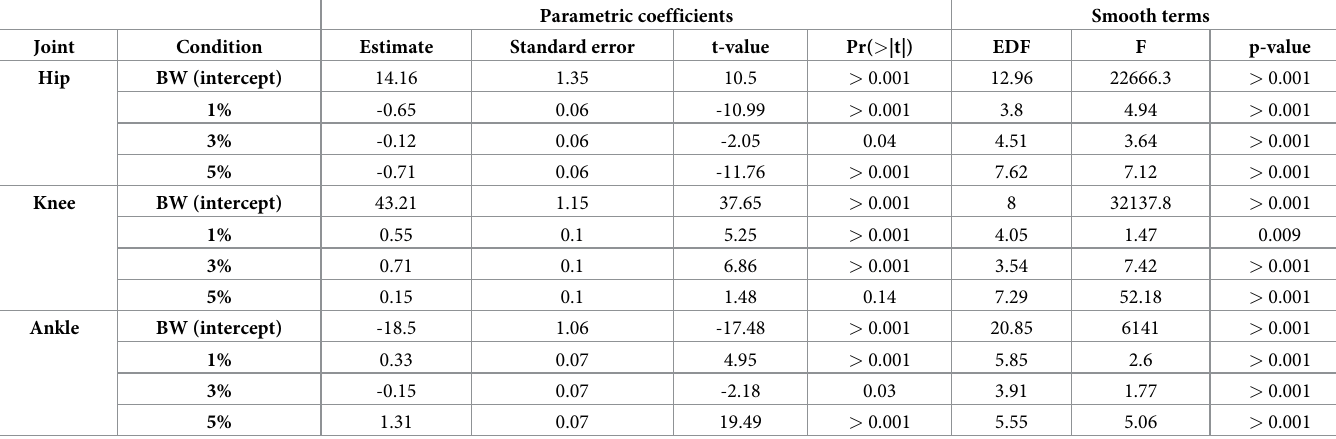
Table 2. Generalised additive model summary statistics